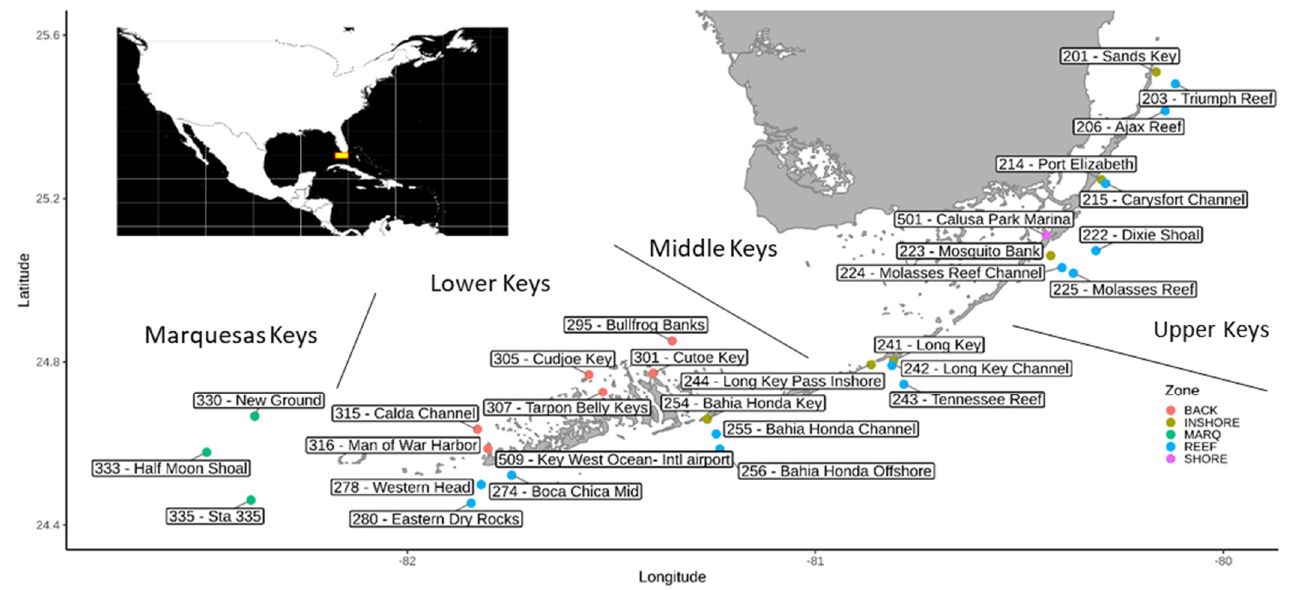
Figure 1. Map of the sampling sites (main graph) and location of the Florida Keys (upper left corner). Sampling sites are color-coded: BACK—Backcountry; INSHORE—Inshore; MARQ—Marquesas Keys; REEF—Reef; SHORE—Shore.